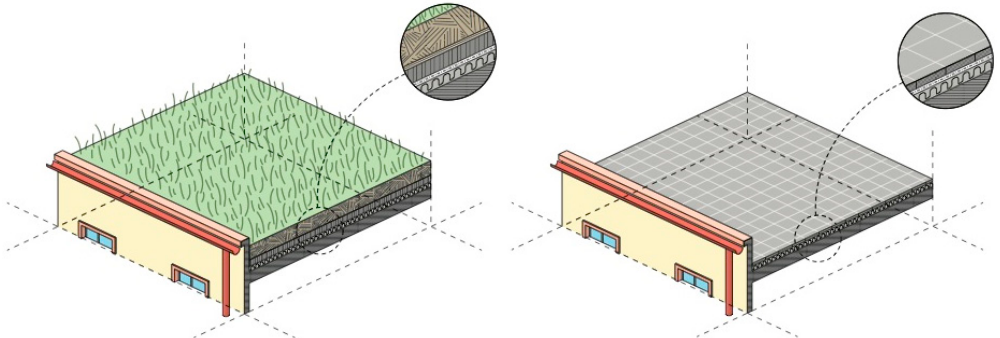
Figure 1. Left: Green roof (layers: slab, insulation material, waterproofing, drainage, filter, substrate, vegetation). Right: traditional roof (layers: slab, insulation material, waterproofing, roof covering).